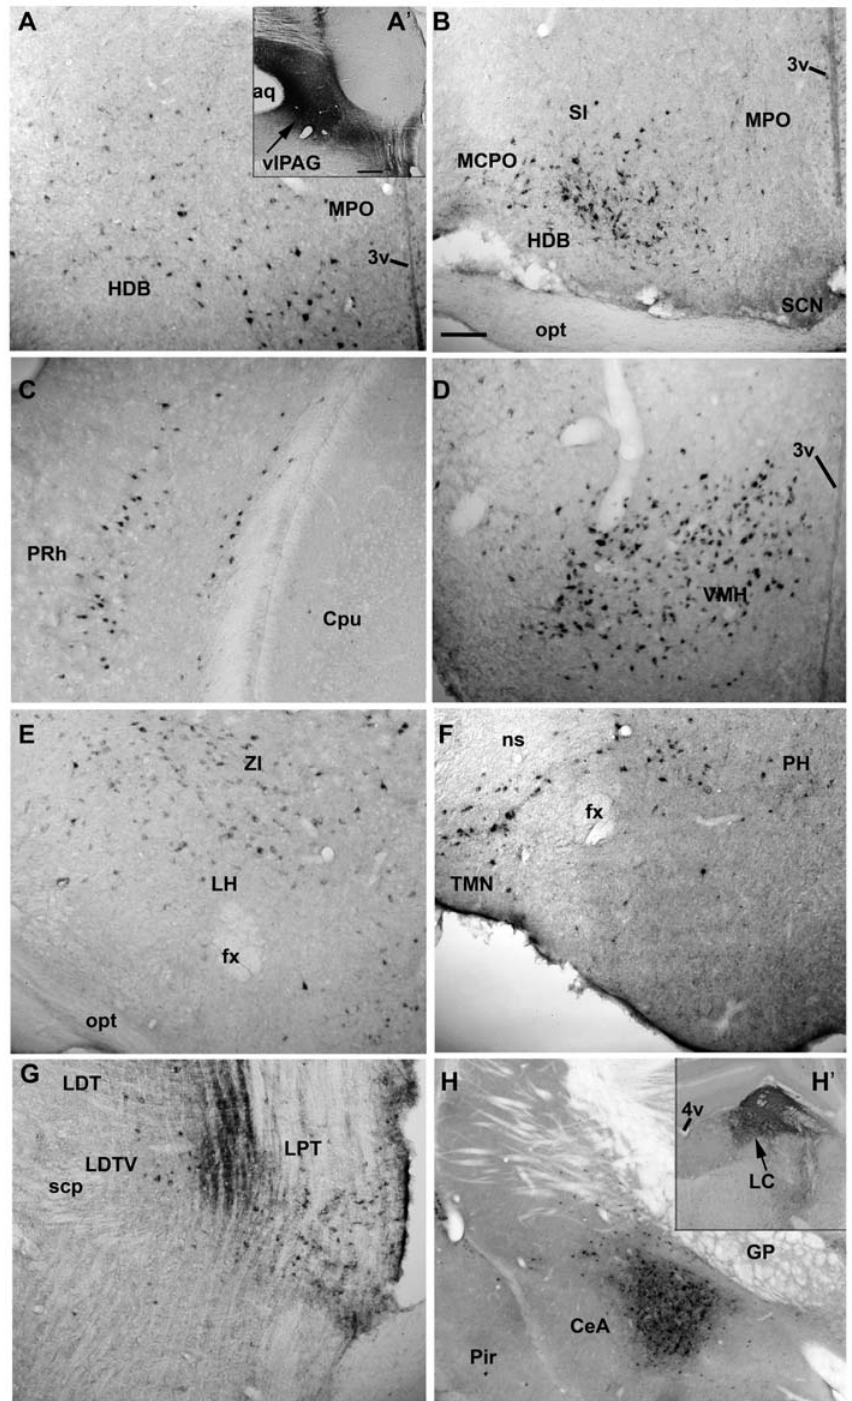
Figure 13. Efferent input to the vl PAG area. An injection of 23 nl of 0.5% CTB in vl PAG (shown the A’) resulted in the retrolabeling of cells in the following areas: A- Basal forebrain (Medial preoptic area): B- Basal forebrain (magnocellular preoptic area); C- Perirhinal cortex; D- ventro-medial hypothamalus; E- lateral hypothalamus; F- tuberomammillary nucleus in the posterior hypothalamus and G- lateral pontine tegmentum. A caudal spread of injection to the locus coeruleus was seen in two cases (shown in H’) and it resulted in retrograde labeling of cells in the amygdala as shown in H. Scale in A’ and H’=200 m m; A-H scale=100 m m.Abbreviations: 3v- third ventricle; 4v- fourth ventricle; aq- aquaduct; CeA- central nucleus of Amygdala; Cpu- caudate putamen; fx- fornix; GP- globus pallidus; HDB- horizontal limb of the diagonal band of broca; LC- locus coeruleus; LDT- dorsolateral tegmentum; LDTV- ventral dorsolateral tegmentum; LH- lateral hypothalamus; LPT- lateral pontine tegmentum; MCPO- magnocellular preoptic area; MPO- medial preoptic; ns- nigrostriatal bundle; opt- optic tract; PH- posterior hypothalamus; Pir- Piriform cortex; PRh- Perirhinal cortex; SCN- suprachiasmatic nucleus; scp- superior cerebellar peduncle; SI- substantia innominata; TMN- tuberomammillary nucleus; vl PAG- ventrolateral preoptic area; VMH- ventromedial hypothalamus.